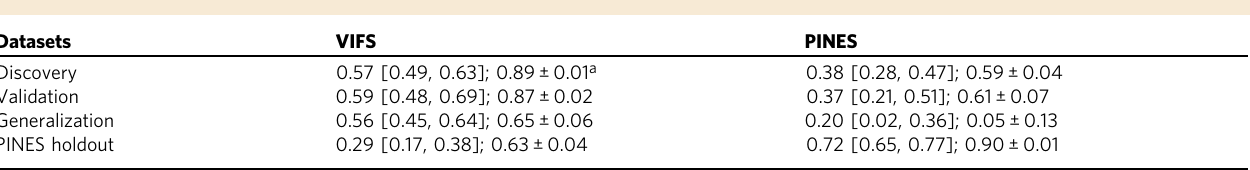
We applied the VIFS and PINES to subjective fear and general negative emotion holdout datasets and calculated the overall (bootstrapped 95% CI) as well as within-subject (mean±SE) prediction − outcome correlations between the pattern expressions and the true ratings. Source data are provided as a Source Data fi le. a indicates